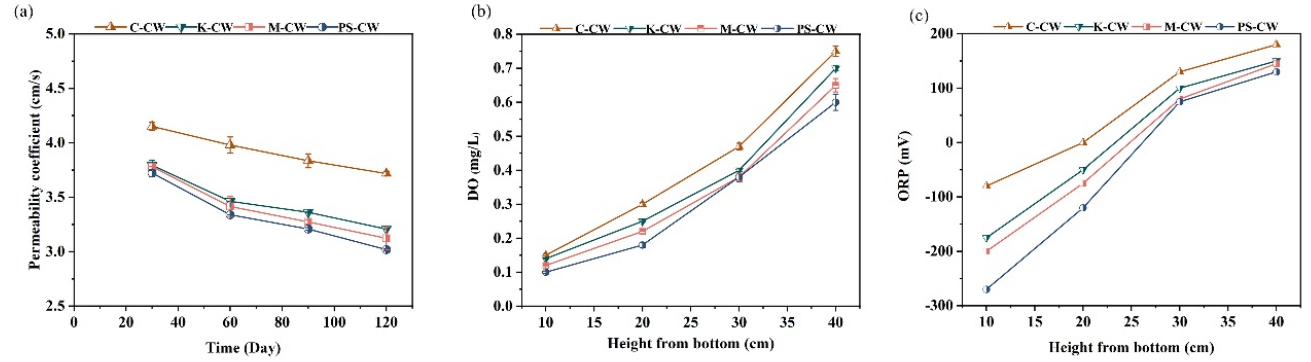
Figure 6. Permeability coefficient ( a ), DO ( b ) and ORP ( c ) in C-CW, K-CW, M-CW and